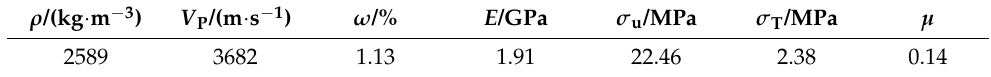
Figure 7. Indirect tensile stress–strain curves.